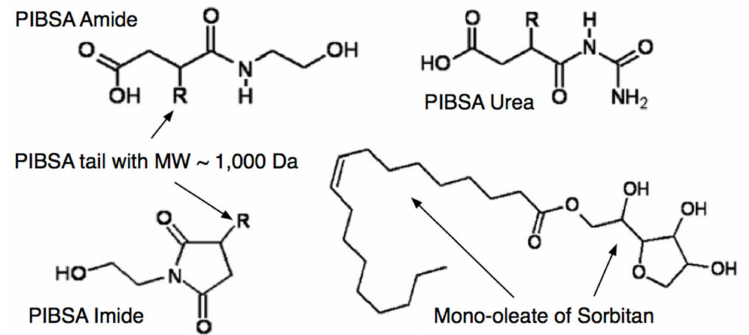
Figure 27. Typical surfactant derivatives used in explosive emulsions, in particular the polyisobuty- lene succinic anhydride (PIBSA) derivatives in which R contains about 20 PIB units.